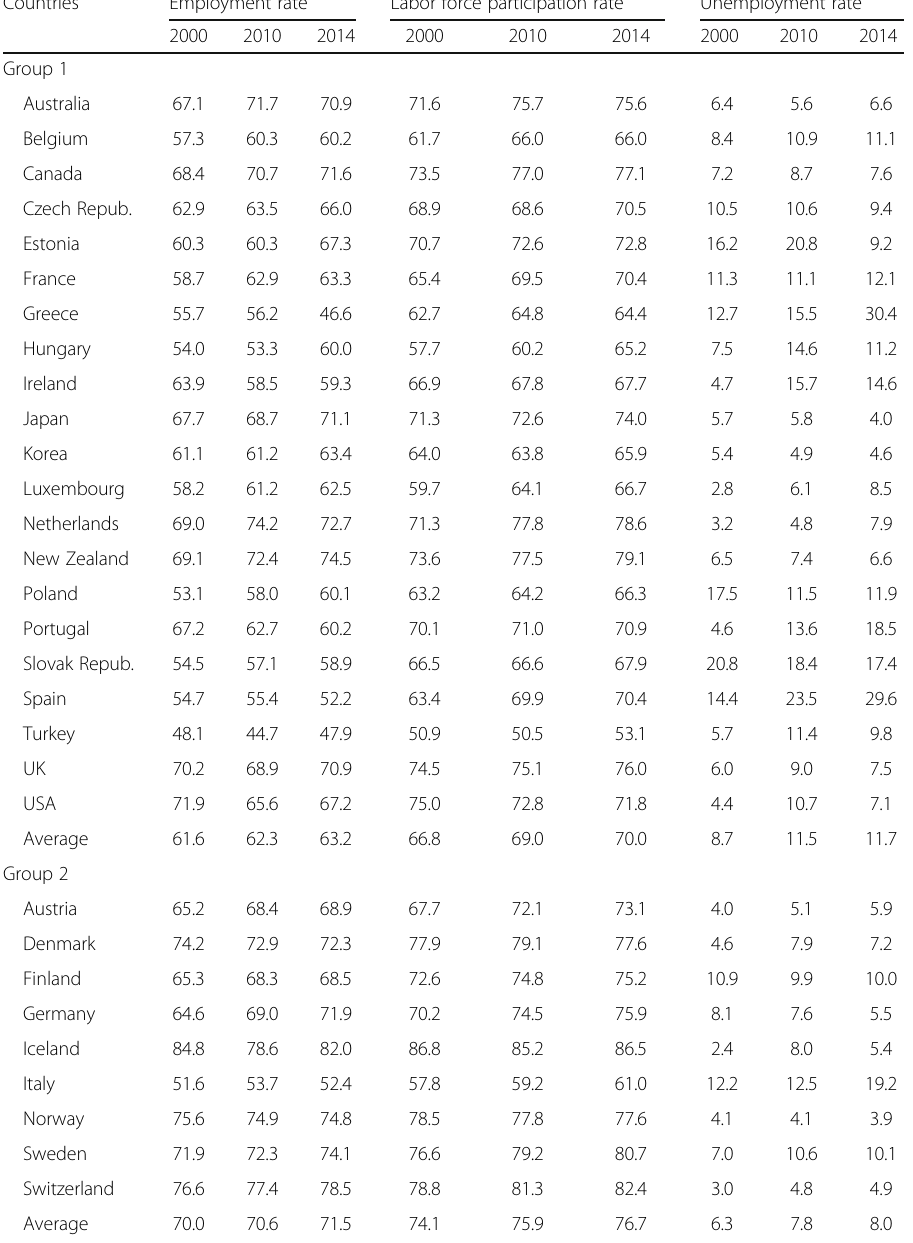
Table 4 Labor market performance variables, 15 – 64 age of population for selected years (2000, 2010, and